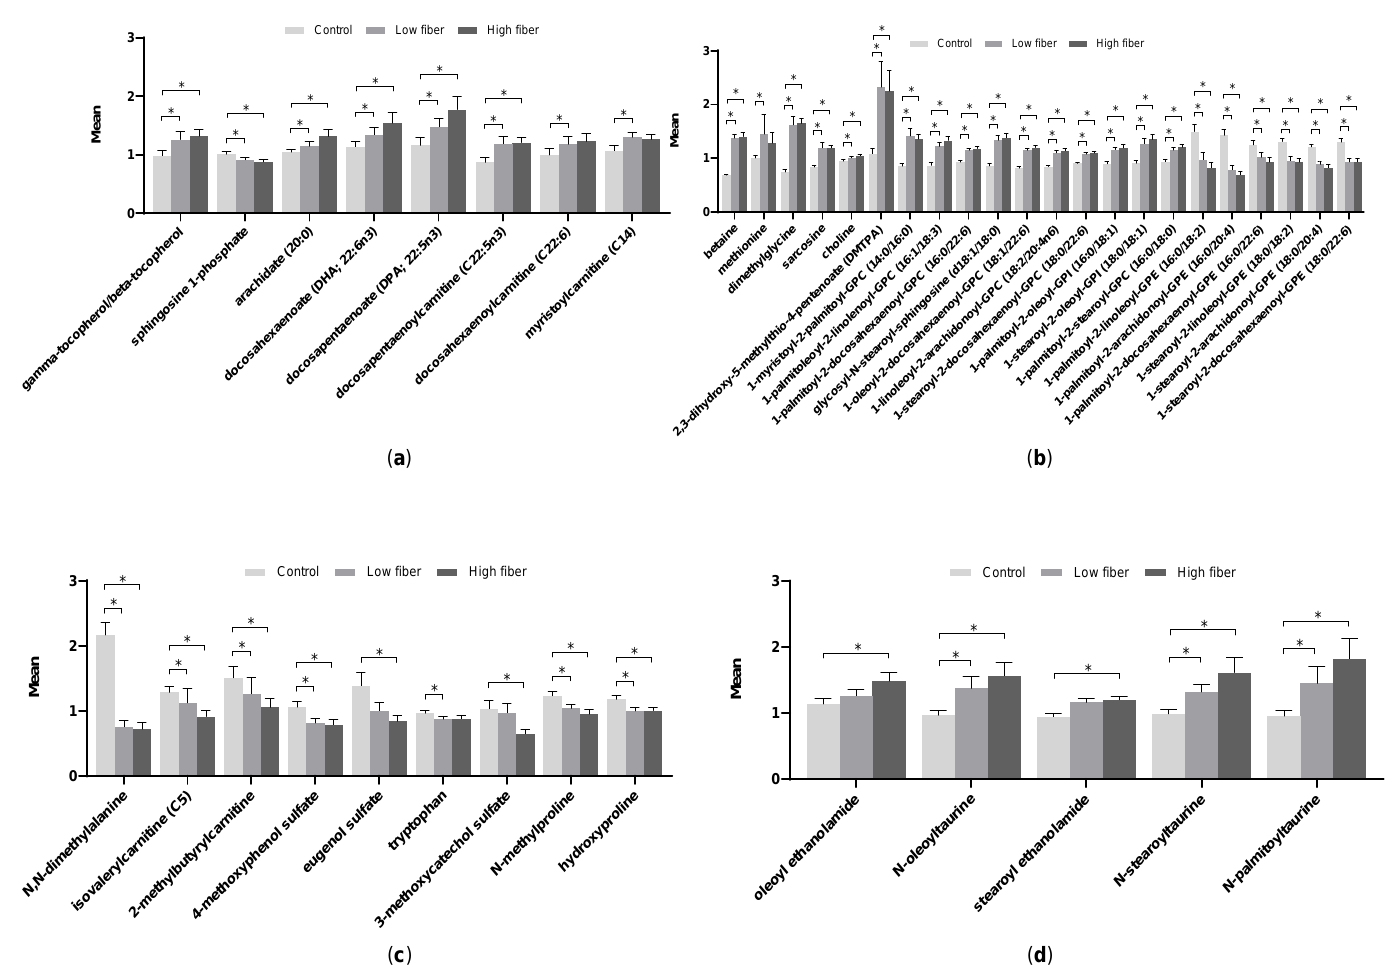
Figure 2. Plasma metabolites from dogs with early renal disease fed the control, low soluble fiber plus betaine, and high soluble fiber plus betaine foods. ( a ) Markers of inflammation and polyunsaturated fatty acids, ( b ) indicators of methylation, ( c ) uremic toxins and collagen breakdown products, and ( d ) endocannabinoids. Data were analyzed via a linear mixed model with animal ID as a random variable, were rescaled to a median value of 1, and are presented as group means and standard errors. * p ≤ 0.05. GPC, glycerophosphocholine; GPE, glycerophosphoethanolamine; GPI,